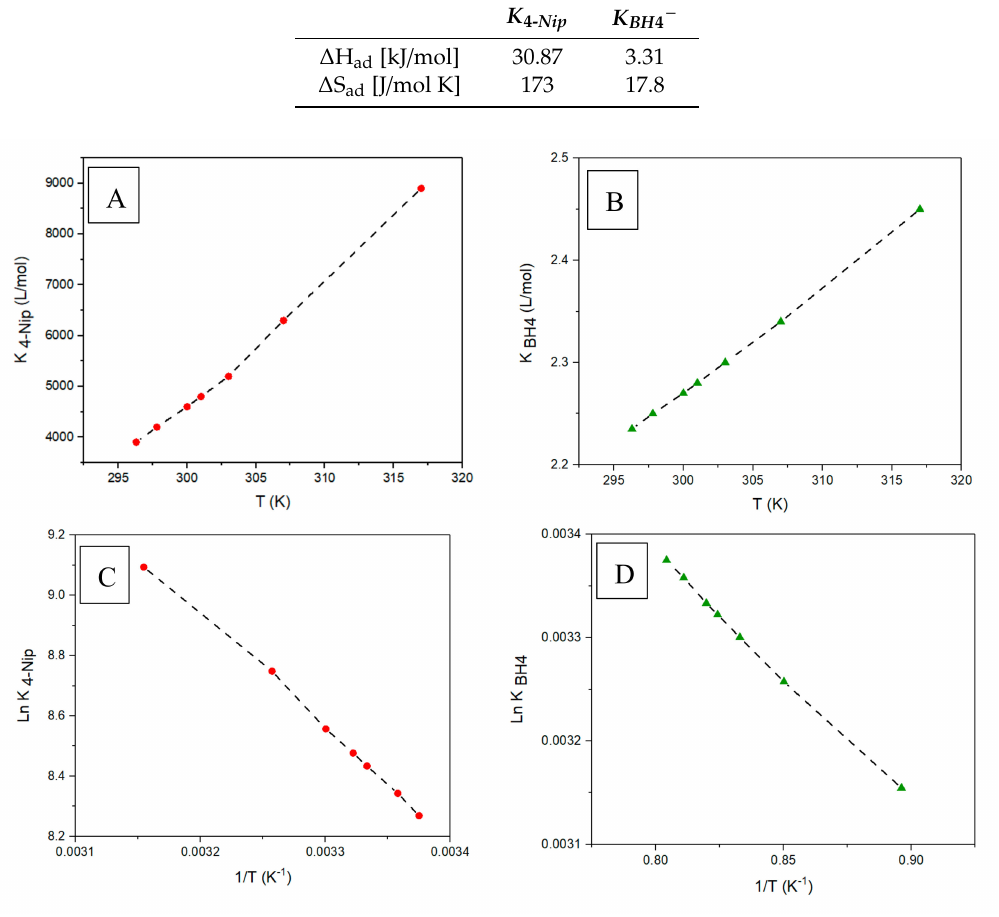
Figure 9. Plots of the adsorption constant K 4- Nip of 4-Nip ( A ) and the adsorption constant K BH 4 − of BH 4 − ; ( B ) versus temperature. The enthalpies and entropies of the adsorption process were calculated from ln( K 4- Nip ) ( C ) and ln( K BH 4 − ) ( D ) based on the inverse of temperature using the van’t Ho ff equation. All values are given in Table